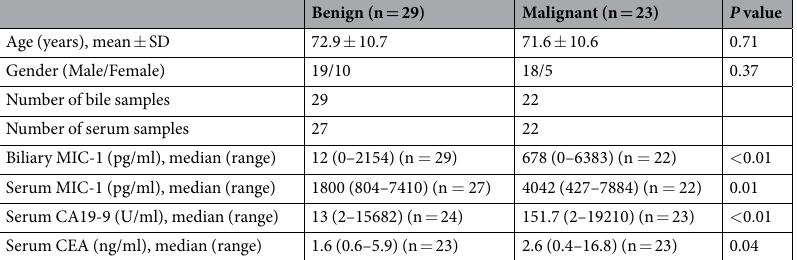
Table 1. Comparison of each marker between the benign and malignant groups. SD , standard deviation; MIC- 1 , macrophage inhibitory cytokine-1.